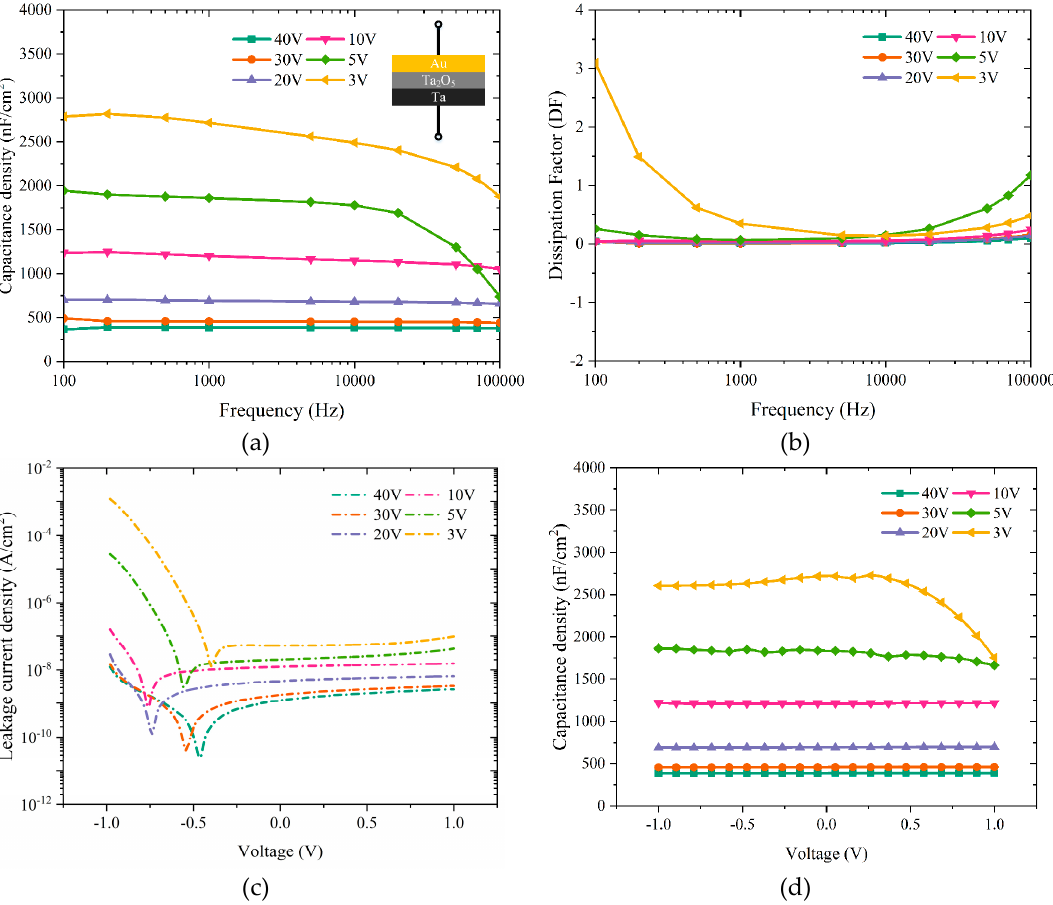
Figure 3. ( a ) Capacitance density and ( b ) dissipation factor vs. frequency, as well as ( c ) leakage current density and ( d ) capacitance density vs. voltage characteristics of the studied Ta/Ta 2 O 5 /Au capacitors.